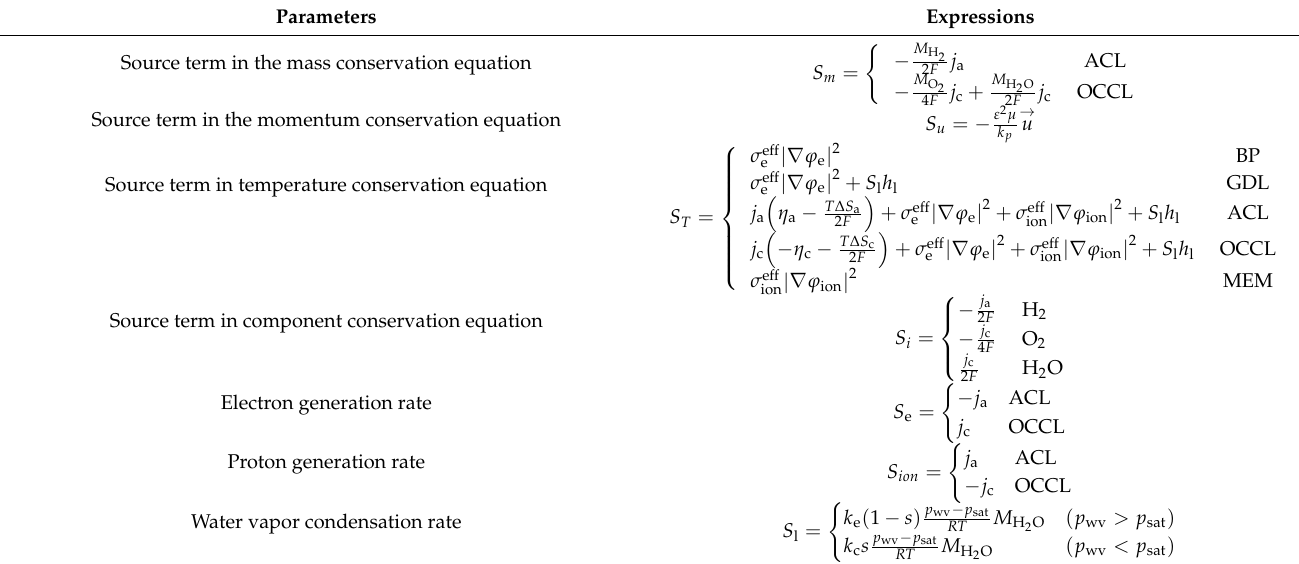
Table 3. Source term